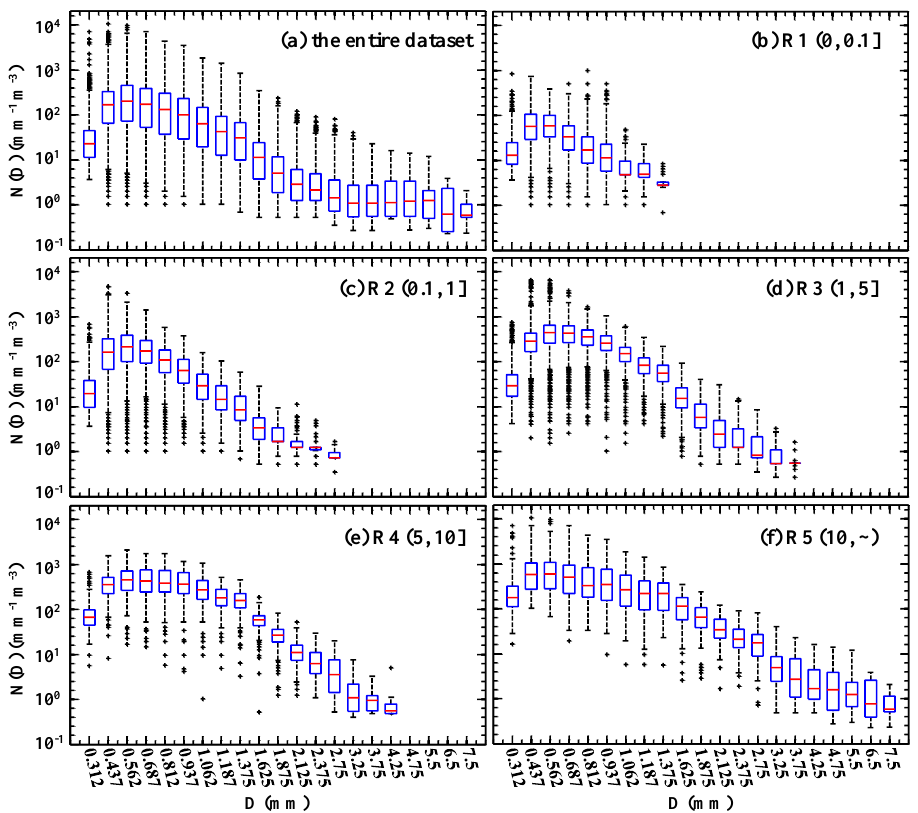
Figure 4. Boxplots of the raindrop size distributions (DSDs) for all datasets ( a ) and sub-datasets of five rain-rate regimes ( b – f ). D and N(D) are the raindrop diameter class and number concentration, respectively. For each boxplot, the bottom and top edges of the blue box indicate the 25th and 75th percentiles, respectively; the red central crossbar represents the median. The black dashed whiskers extend to the maximum and minimum of the data points, respectively, and the outliers are plotted individually using the “+” symbol.